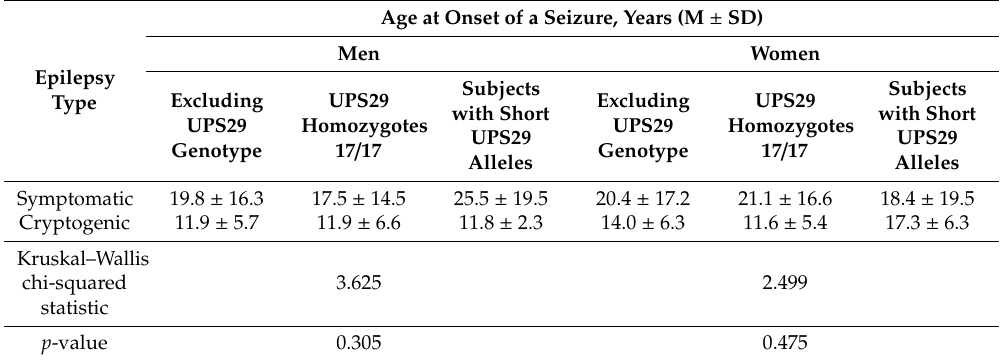
Table 3. The age at onset of epilepsy and UPS29 genotypes.